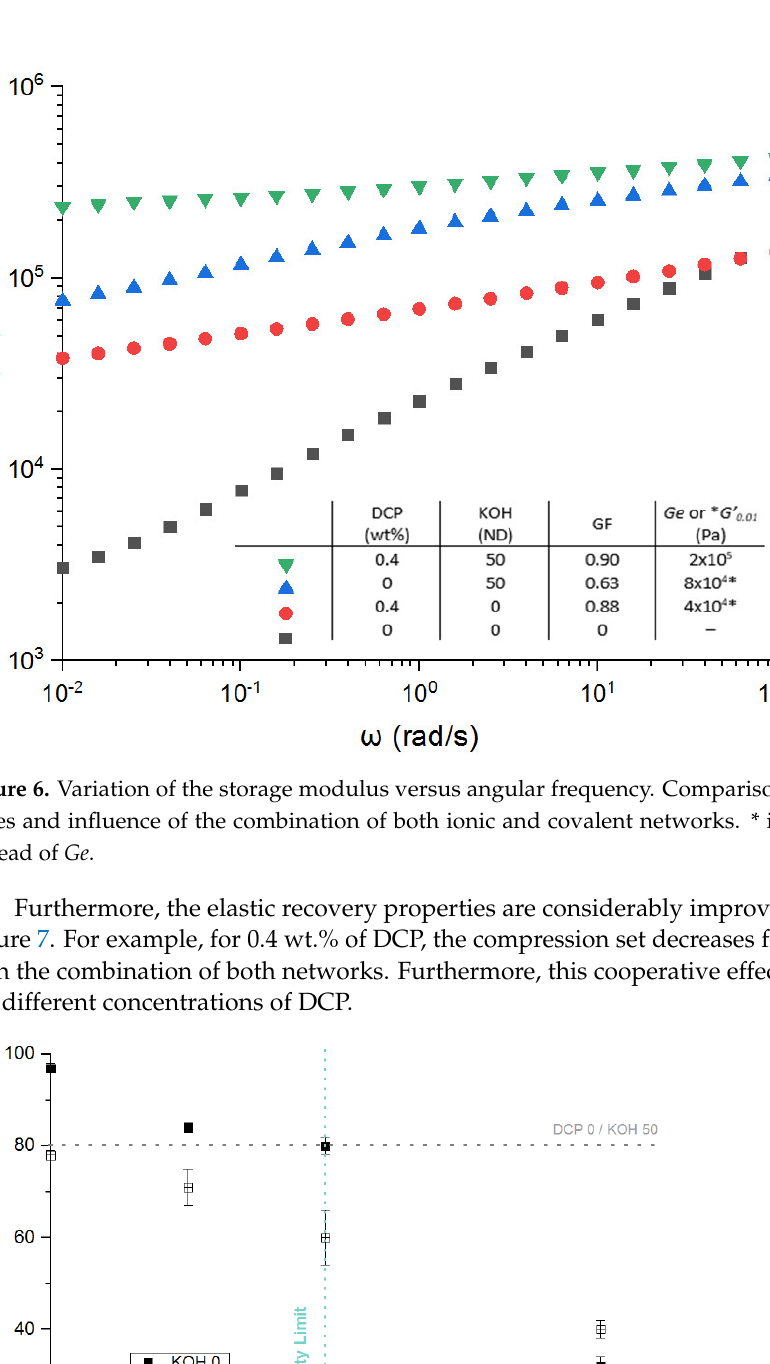
Figure 7. Variation of the compression set versus DPC concentration. Influence of the combination of both ionic and covalent networks.